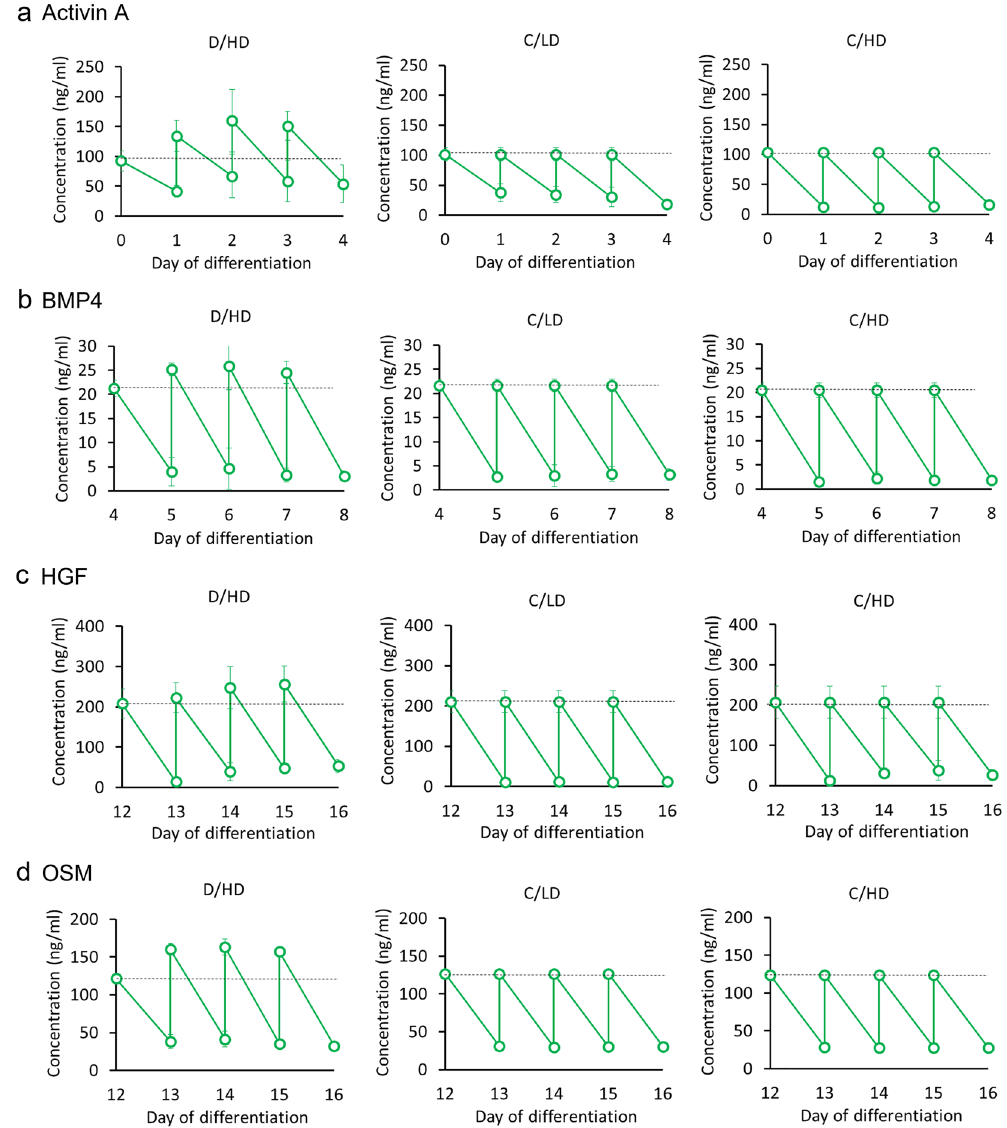
Figure 4. Growth factor accumulation for each culture configuration used in this study. The dialysis culture system (D/HD) successfully accumulated the four primary growth factors for hepatic differentiation, ( a ) activin A, ( b ) BMP4, ( c ) HGF, and ( d ) OSM contributed to hiPSCs derived liver organoids (HLOs) during their specific differentiation stage. (n = 4 biologically independent experiments). The dotted line indicates growth factor concentration in the differentiation